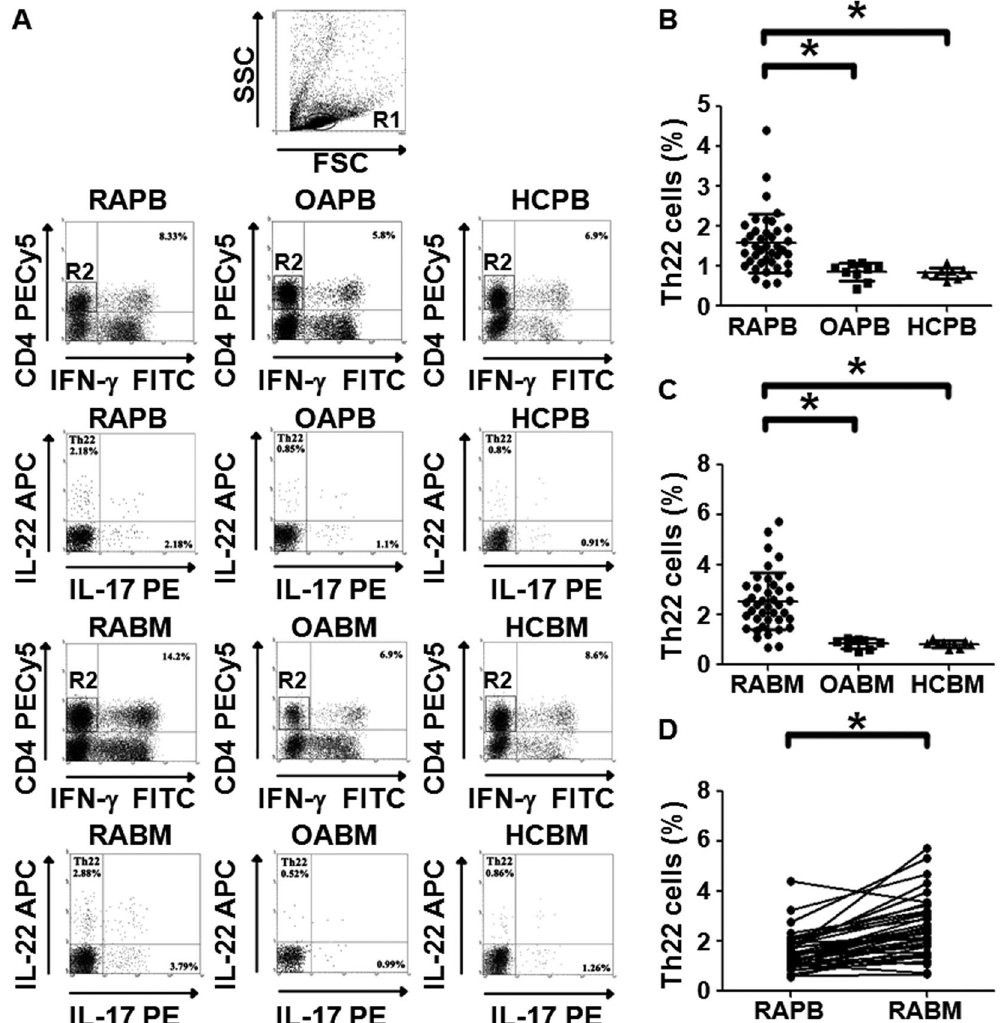
Figure 1. Frequency of Th22 based on cytokine patterns after in vitro activation by PMA/ionomycin in short- term cultures. ( A ) Flow cytometry for the detection of the frequency of Th22. ( B ) The percentages of Th22 in peripheral blood from rheumatoid arthritis patients (RAPB), osteoarthritis patients(OAPB) () and healthy controls (HCPB). ( C ) The percentages of Th22 in bone marrow blood from rheumatoid arthritis patients (RABM), osteoarthritis patients(OABM) and healthy controls (HCBM). ( D ) The percentages of Th22 in peripheral blood (RAPB) and bone marrow blood (RABM) from rheumatoid arthritis patients. * P <